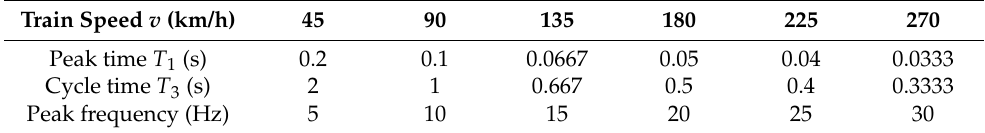
Table 5. Characteristic parameter of the actuator loading time–history curve. Train Speed v (km/h)